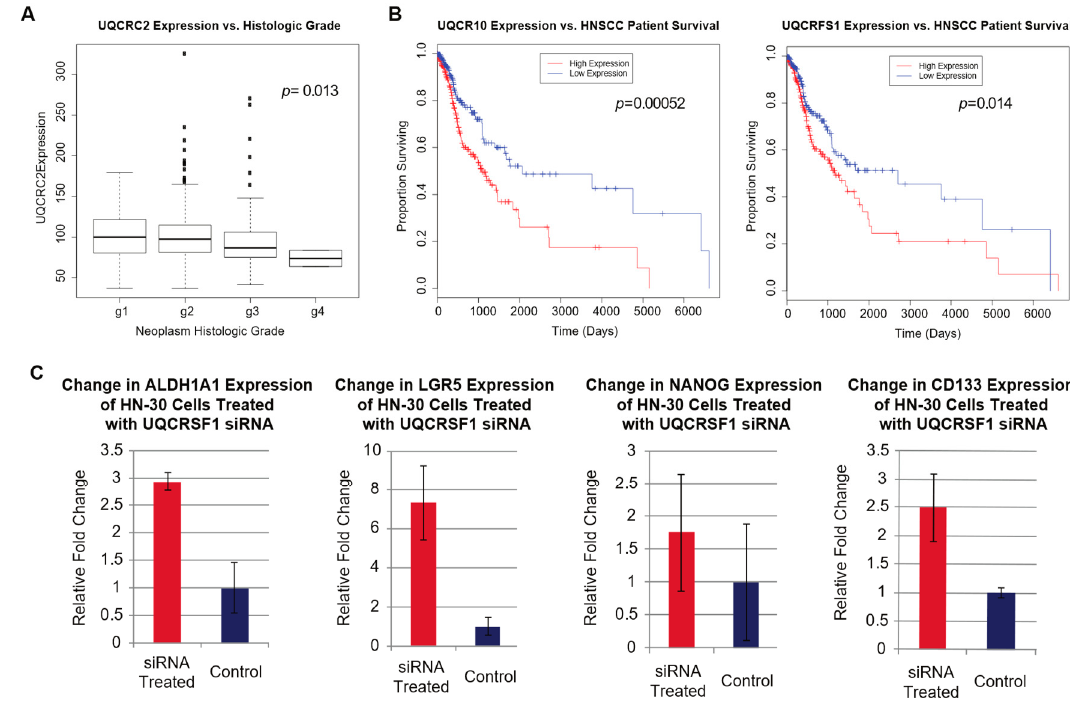
Figure 4. Correlation of complex III gene expressions with clinical variables and stem cell marker expressions. ( A ). Correlation of decreasing UQCRC2, one of the two core protein subunits of complex III, expression with increasing histologic grade of HNSCC patient samples using the Kruskal-Wallis